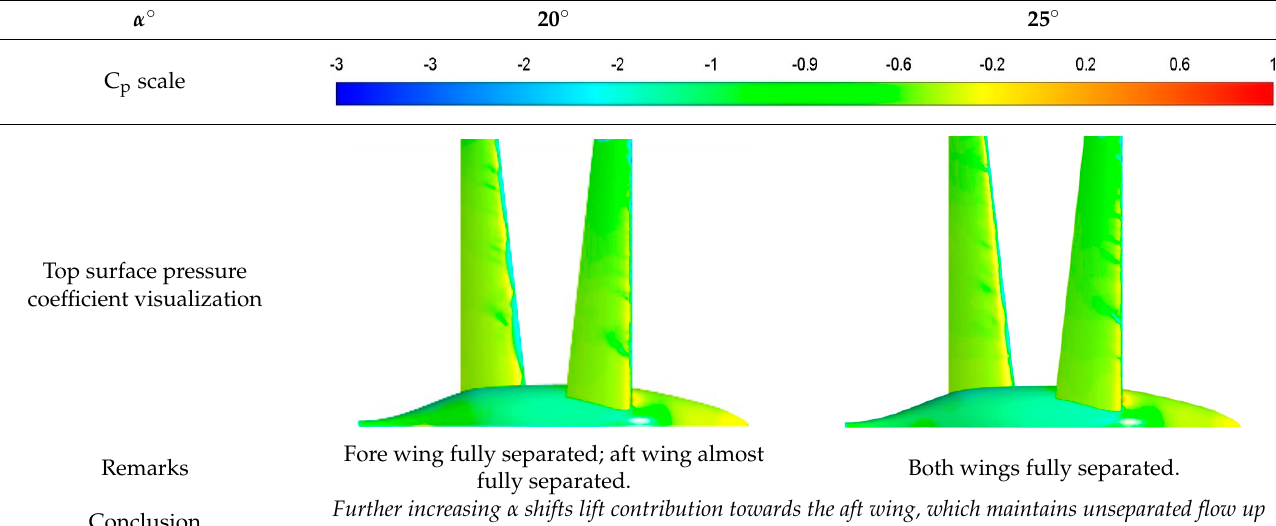
Table 4. Top surface pressure coefficient visualization at different angles of attack and conclusions about flow separation beyond the stalled region of the lift curve.